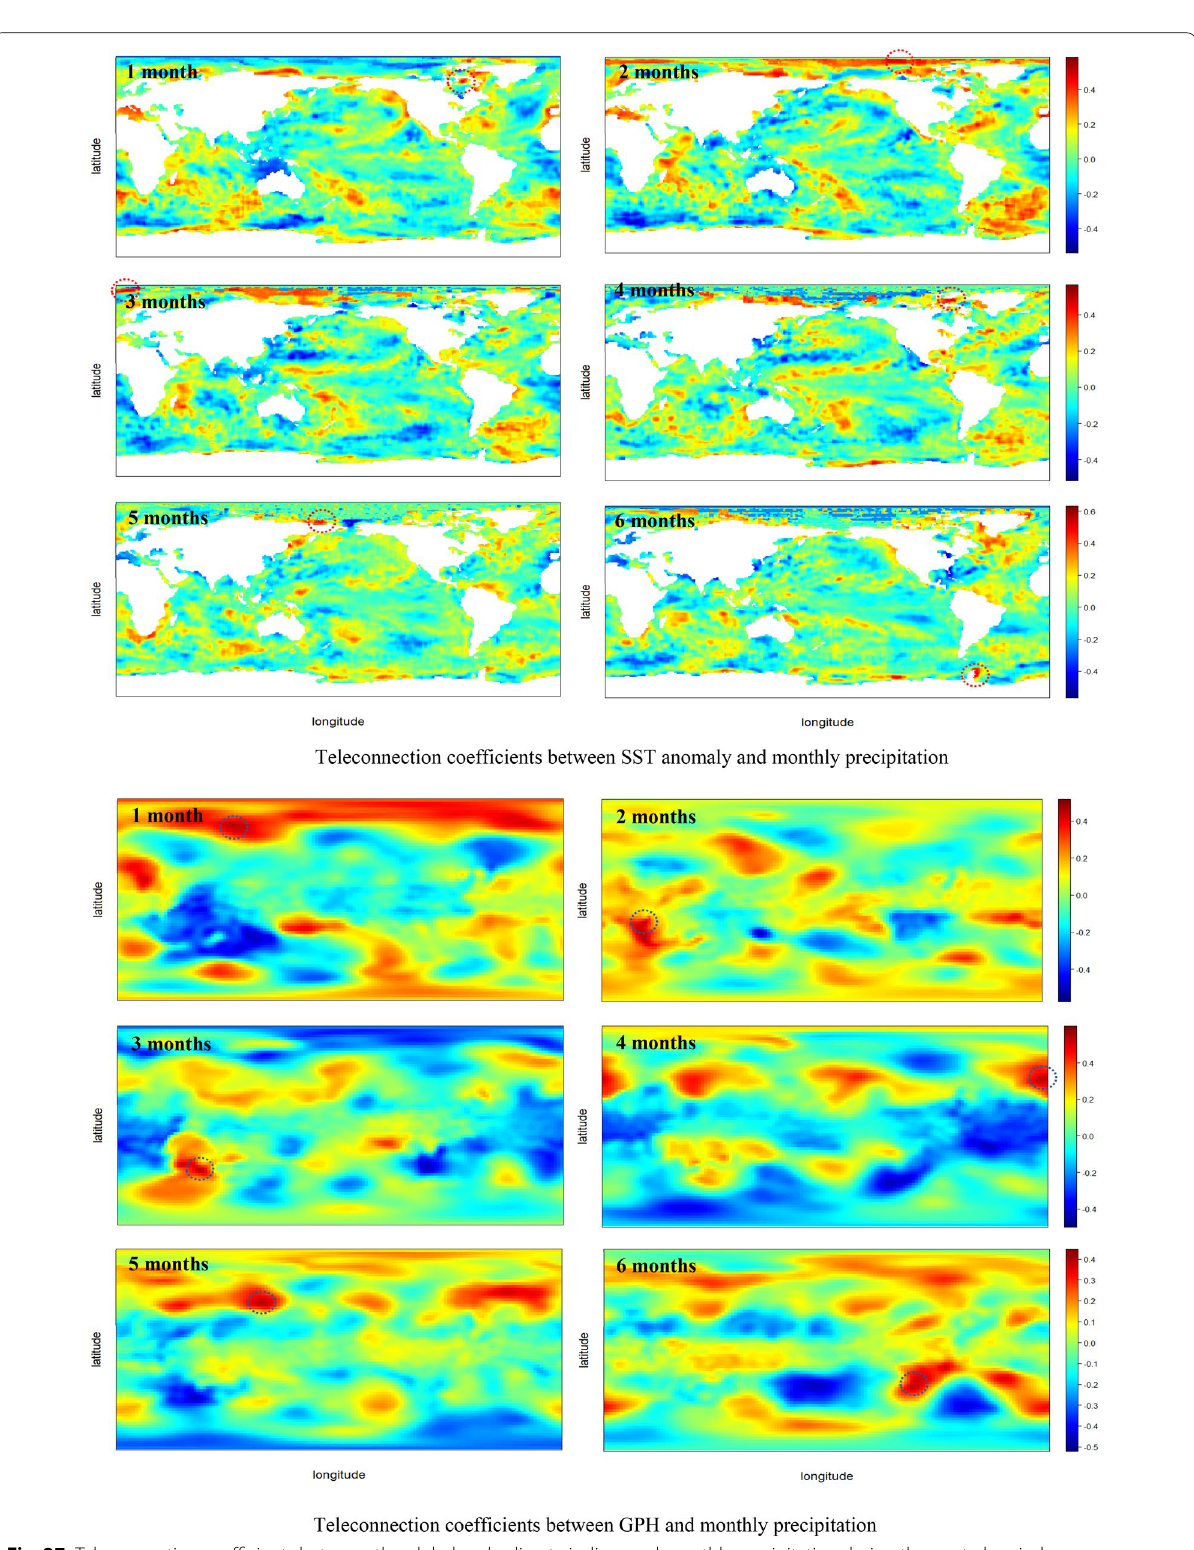
Fig. 27 Teleconnection coefficients between the global-scale climate indices and monthly precipitation during the neutral